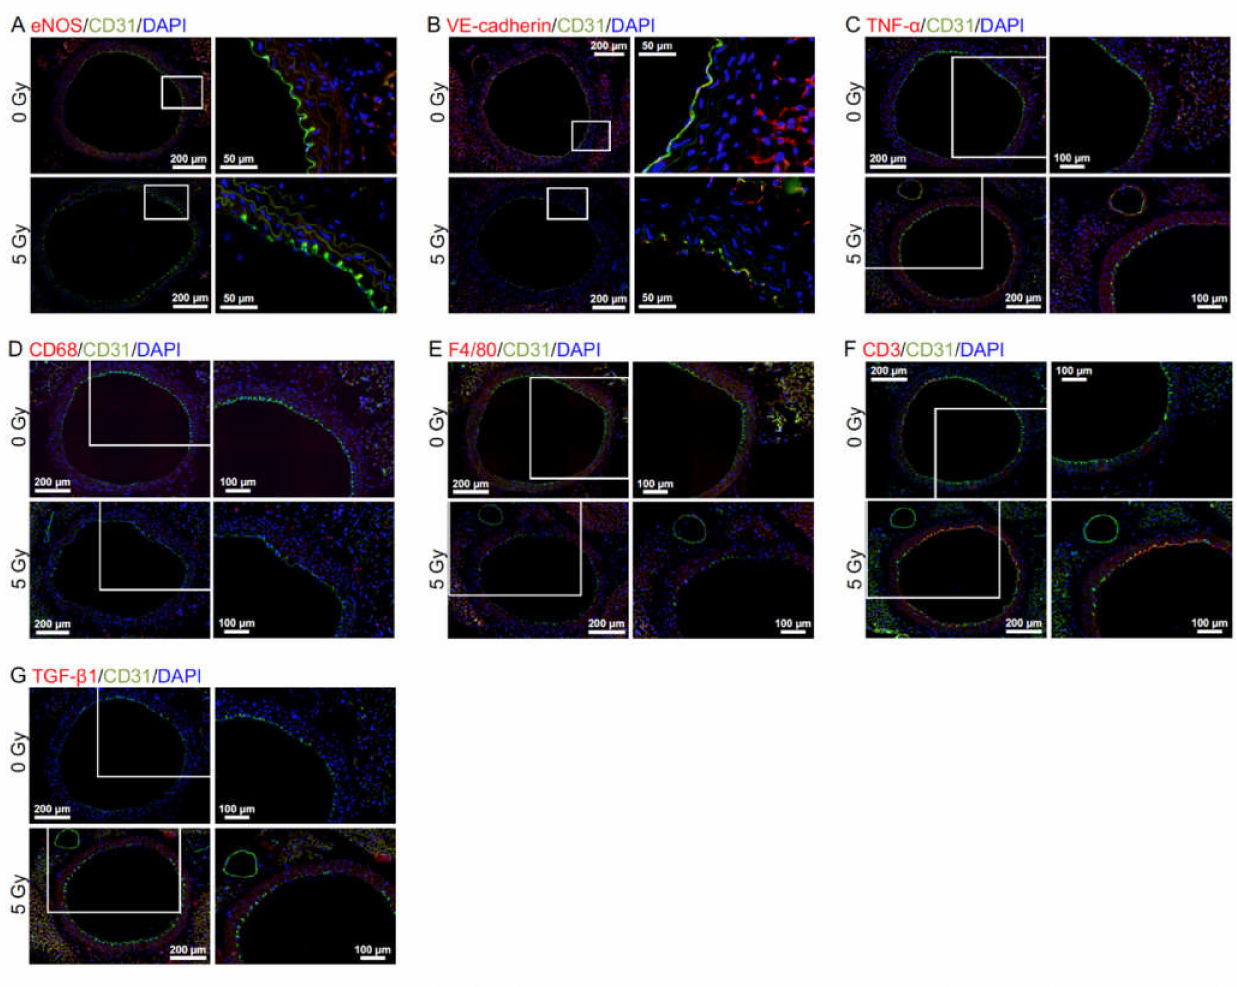
Figure 2. Molecular alterations in the aorta. Representative merged images (all at 12 mos ASI) for double immunofluorescence of CD31 with ( A ) eNOS, ( B ) VE-cadherin, ( C ) TNF- α , ( D ) CD68, ( E ) F4/80, ( F ) CD3 or ( G ) TGF- β 1, with cell nuclei counterstained with DAPI. ( A , C – G ) X-rays in 25 Frs. ( B ) Acute X-rays. Upper panels, 0 Gy. Lower panels, 5 Gy. Boxed areas in the left panels (tiled images) are presented at higher magnification in the right panels. Scale bars are as